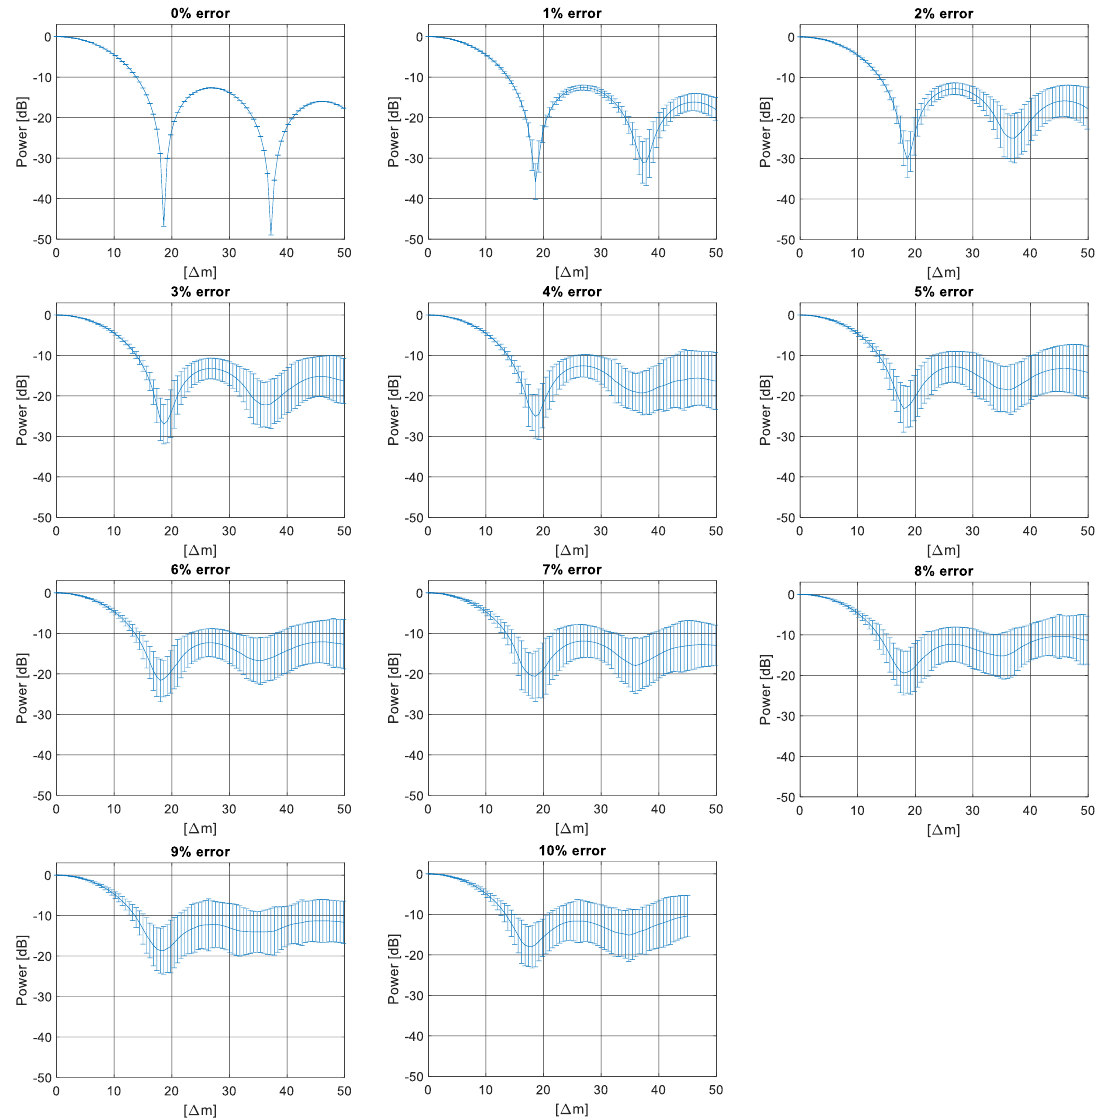
Figure 11. Tomographic SAR systems offer the possibility of focusing on specific depths by attenuating the radar echoes coming from surrounding elevations; the vertical discrimination can be appreciated by analyzing the impulse response functions (IRFs) here shown. The elevation of interest is here set around 0 m (with respect to a given reference height) that is, where the IRFs reach the maximum value. The attenuation of the echoes coming from other elevations is shown in dB in the vertical axis, being the horizontal axis the distance from the desired elevation in meters. Irregularities in the baseline distribution modify the IRF and worsen the capability of the tomographic system of rejecting undesired radar echoes. The panels here shown correspond to the sensor positions shown in Figure 10. 10 outcomes of the Gaussian noise perturbing the baselines have been generated for each perturbation intensity (going from 0% to 10% of the critical baseline); the average IRF, together with the ± 1 σ errorbars are here